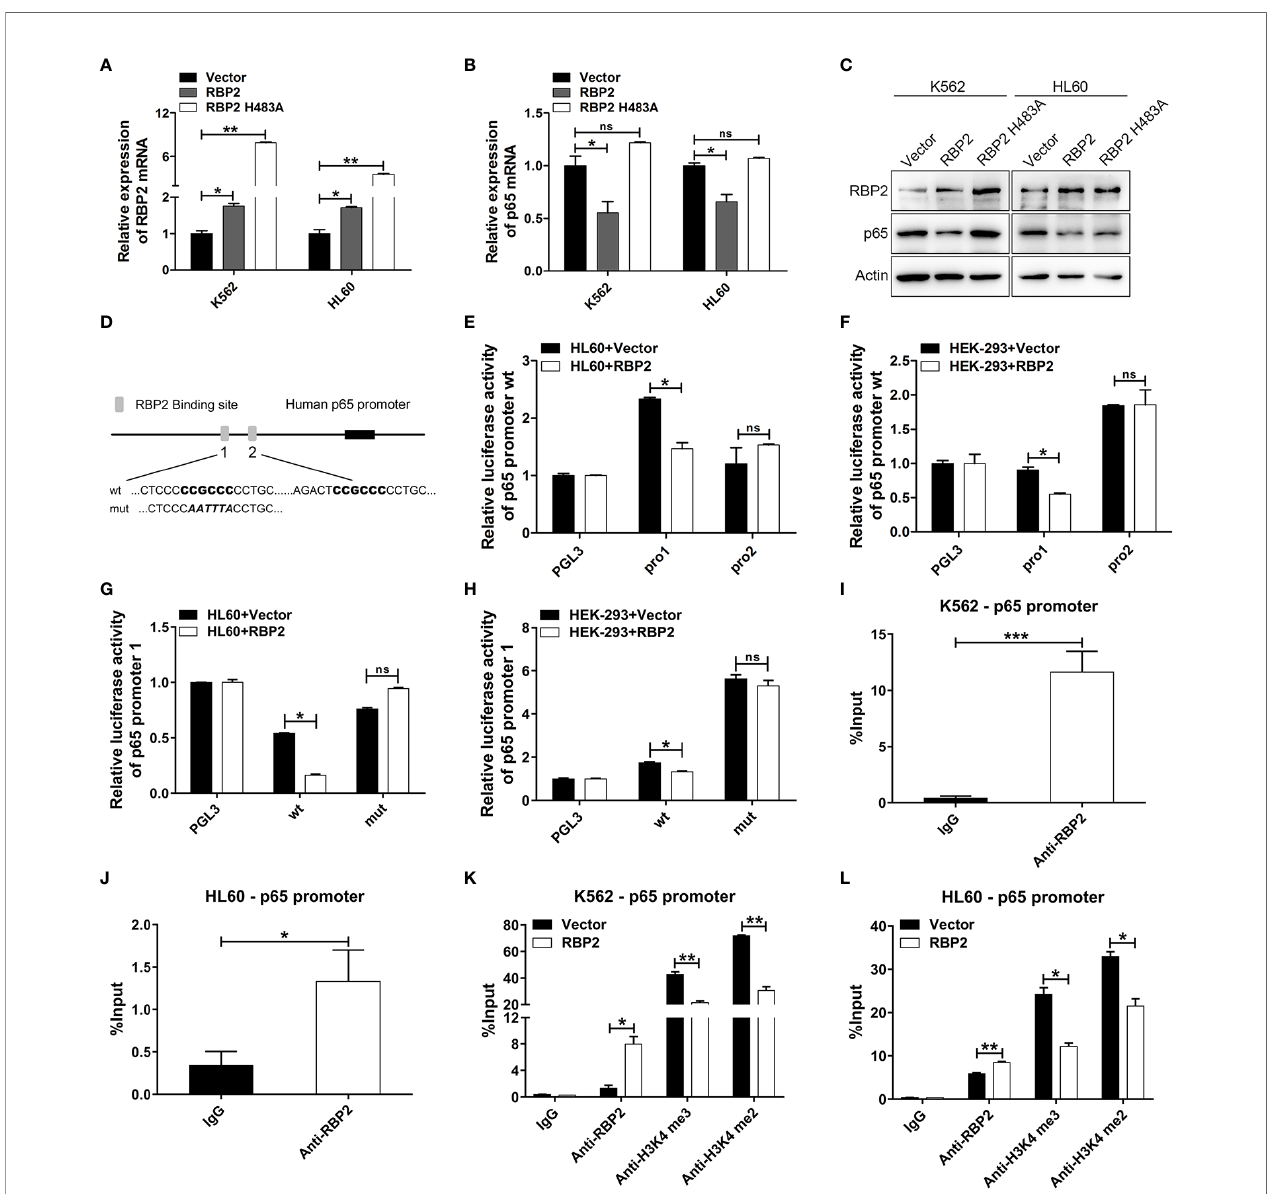
FIGURE 3 | p65 is directly and epigenetically downregulated by RBP2. (A, B) qRT-PCR of RBP2 and p65 mRNA level after transfection with RBP2 wild-type or RBP2-mutant (defective in demethylase activity, RBP2 H483A) plasmids in K562 and HL60 cells. (C) Western blot analysis of RBP2 and p65 protein expression levels after transfection with RBP2 wild-type or RBP2 H483A plasmids in K562 and HL60 cells. (D) Schematic illustration of the predicted RBP2 binding sites in the p65 promoter. (E, F) Regulation of p65 wild-type promoter by RBP2, including the fi rst RBP2 binding site (p65 pro1) and the second RBP2 binding site (p65 pro2). HL60 and HEK-293 cells were transfected with p65 wild-type reporters, together with RBP2 expression plasmids, followed by luciferase activity assessment 48 h post-transfection. (G, H) p65 wild-type pro1 and its mutated activity following RBP2 wild-type plasmids transfection in HL60 and HEK-293 cells. (I, J) ChIP assay for RBP2 binding to the p65 promoter in K562 and HL60 cells. (K, L) The binding of RBP2 and H3K4me3/2 to p65 promoter after RBP2 plasmid transfection in K562 and HL60 cells. The results are from 3 independent experiments. * p < 0.05, ** p < 0.01, *** p < 0.001, ns, not statistically signi fi